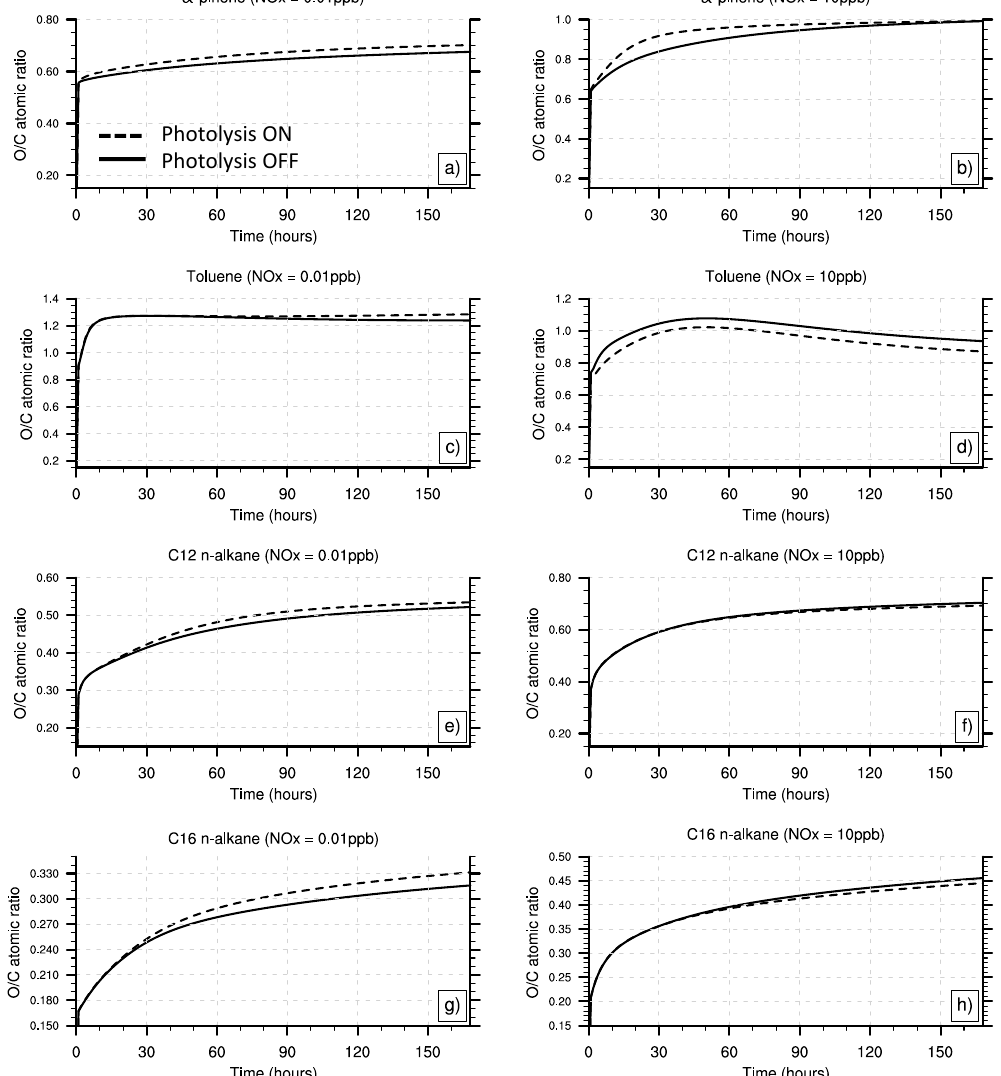
Figure 3. Oxygen to carbon (O/C) ratios as predicted by the BASE case simulation with (dashed lines) and without (solid lines) gas-phase photolysis of